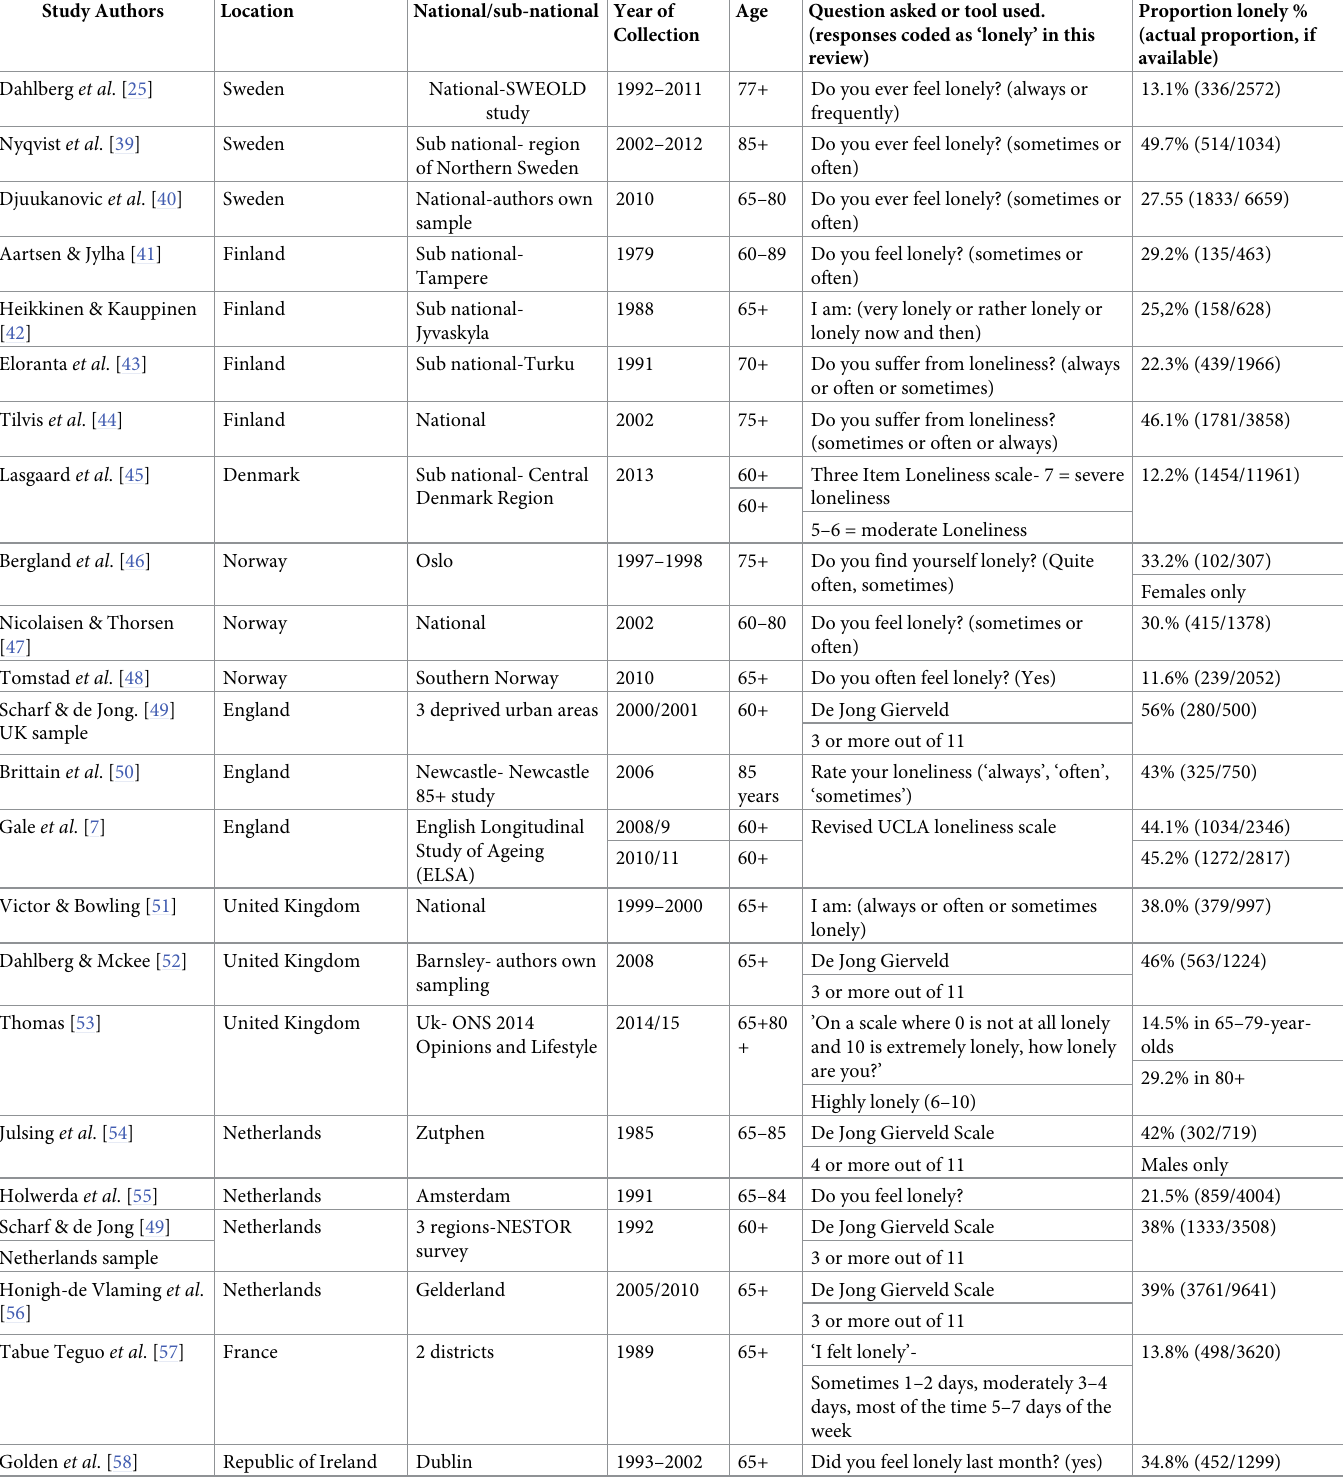
Table 1. Summary of details and findings of studies included in the